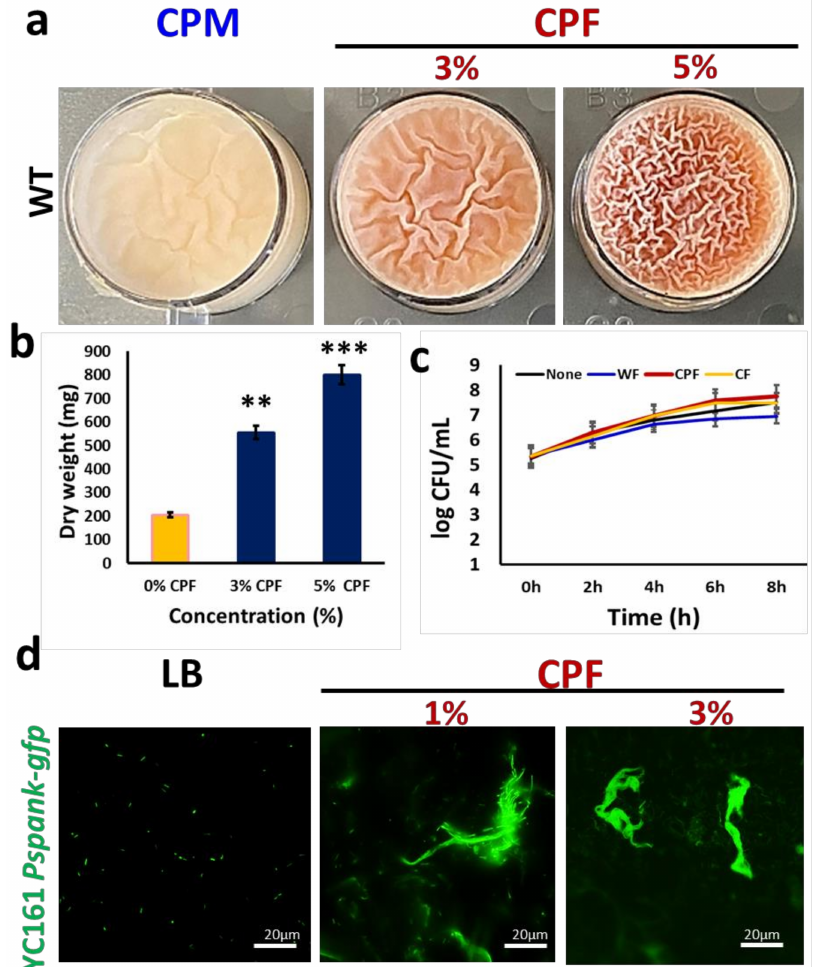
Figure 1. Induction in biofilm formation by B. subtilis in response to chickpea fiber (CPF): ( a ) pellicle formation by WT B. subtilis in chickpea milk (CPM) with or without supplementation of either 3 or 5% of CPF; ( b ) quantification of pulcherrimin production by B. subtilis in the presence of either 3 or 5% of CPF. The graph shows the means ± SEMs of three measurements. ** p < 0.01 and *** p < 0.001 vs. the non-treated controls; ( c ) growth curve analysis of WT B. subtilis during incubation in the fiber’s enriched media. Cells grown for 8 h in LB supplemented with different prebiotic substances were sampled every 2 h to determine the viable cell counts; ( d ) interaction of fluorescently tagged B. subtilis cells (YC161, harboring the green fluorescence protein as a reporter) with CPF (1 or 3%) during growth for 16 h in LB